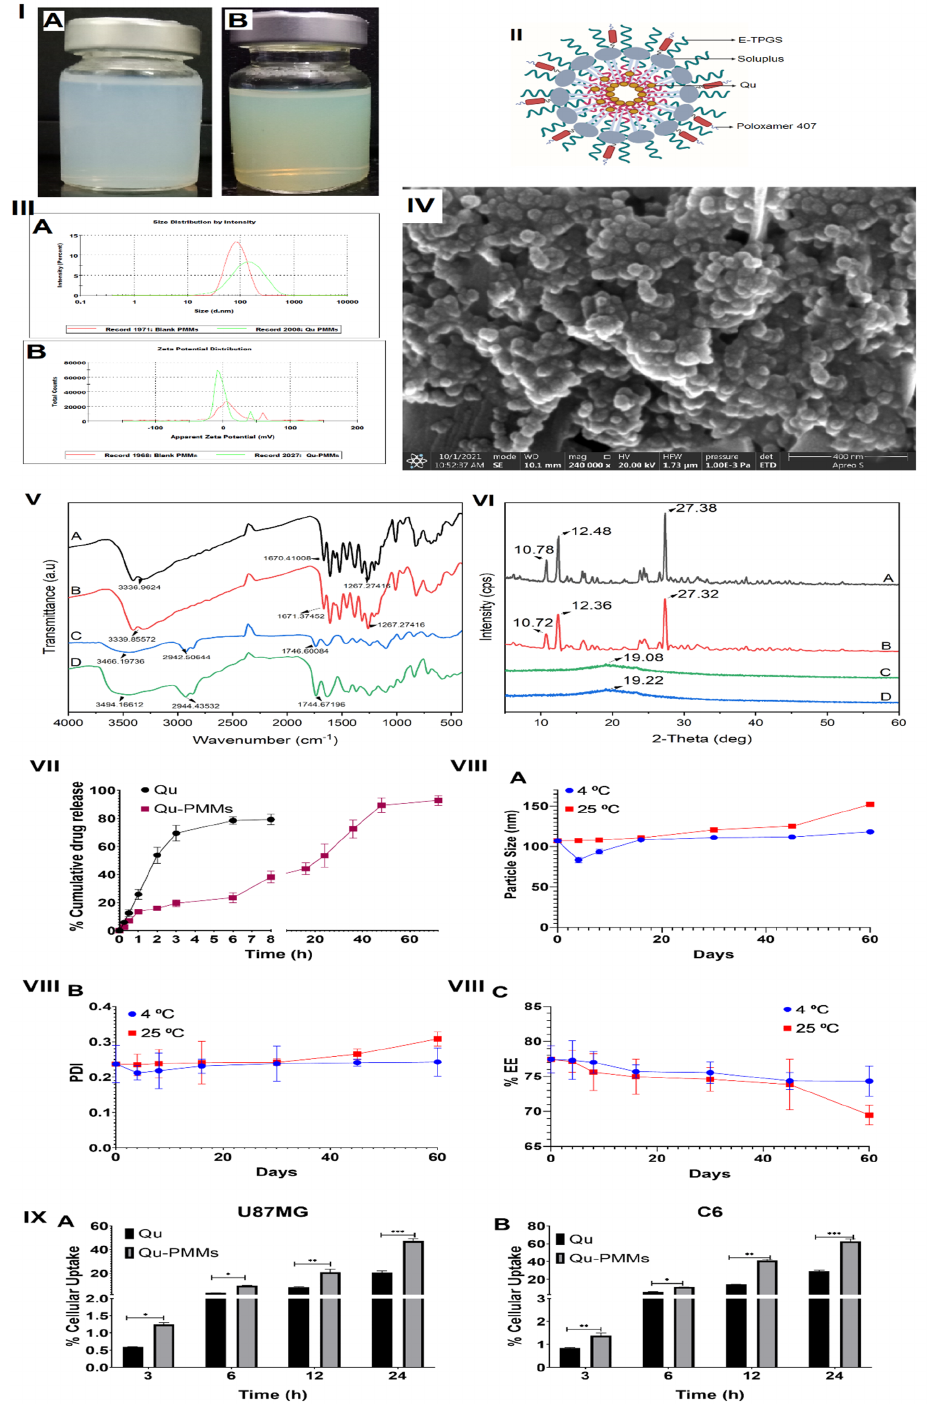
Figure 2. In vitro evaluations of optimized Qu-PMMs; ( I ) Physical appearance of ( A ) blank PMMs and ( B ) Qu-PMMs optimized formulation; ( II ) Schematic illustration of Qu-PMMs; ( III ) Particle size ( A ) and zeta potential ( B ) analysis of blank PMMs and Qu-PMMs; ( IV ) Scanning electron microscopy (SEM) morphology evaluation of Qu-PMMs; ( V ) Drug release profile of Qu-PMMs; ( VI ) Stability analysis of ( A ) PS, ( B ) PDI, and ( C ) % EE; IX. In vitro % cellular uptake of ( A ) U87MG and ( B ) C6 cells on Qu and Qu-PMMs treatment. Data are represented in means ± Standard deviation ( n = 3). * Indicates p < 0.05, ** represents p < 0.01 and *** represents p < 0.001 (Qu PD vs.